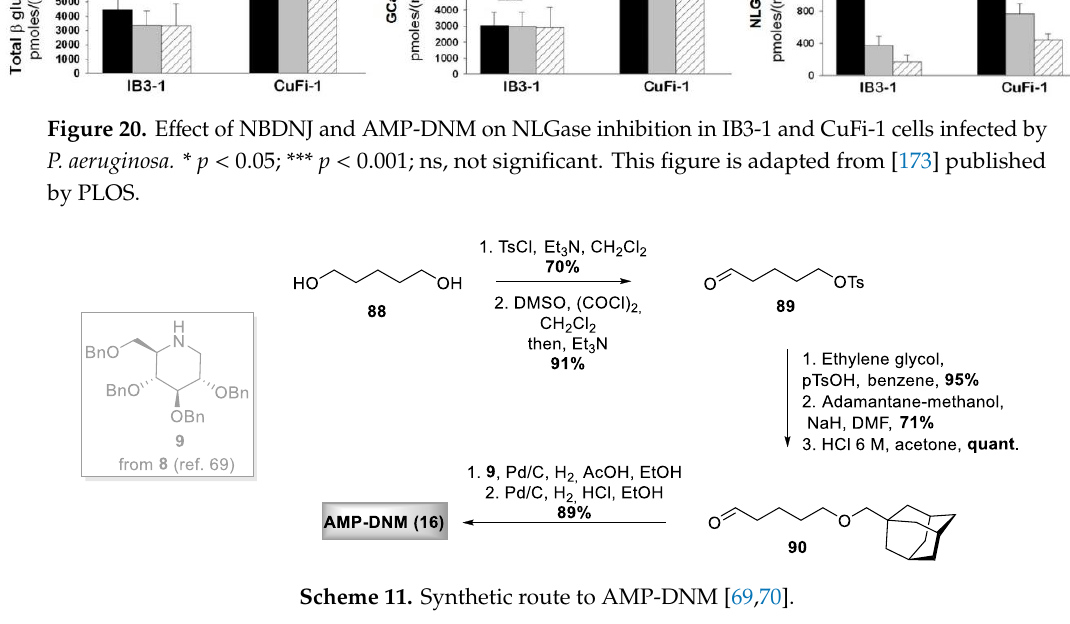
Table 2. Inhibition of P. aeruginosa stimulated IL-8 mRNA expression in CuFi cells. (Reproduced from [176]).